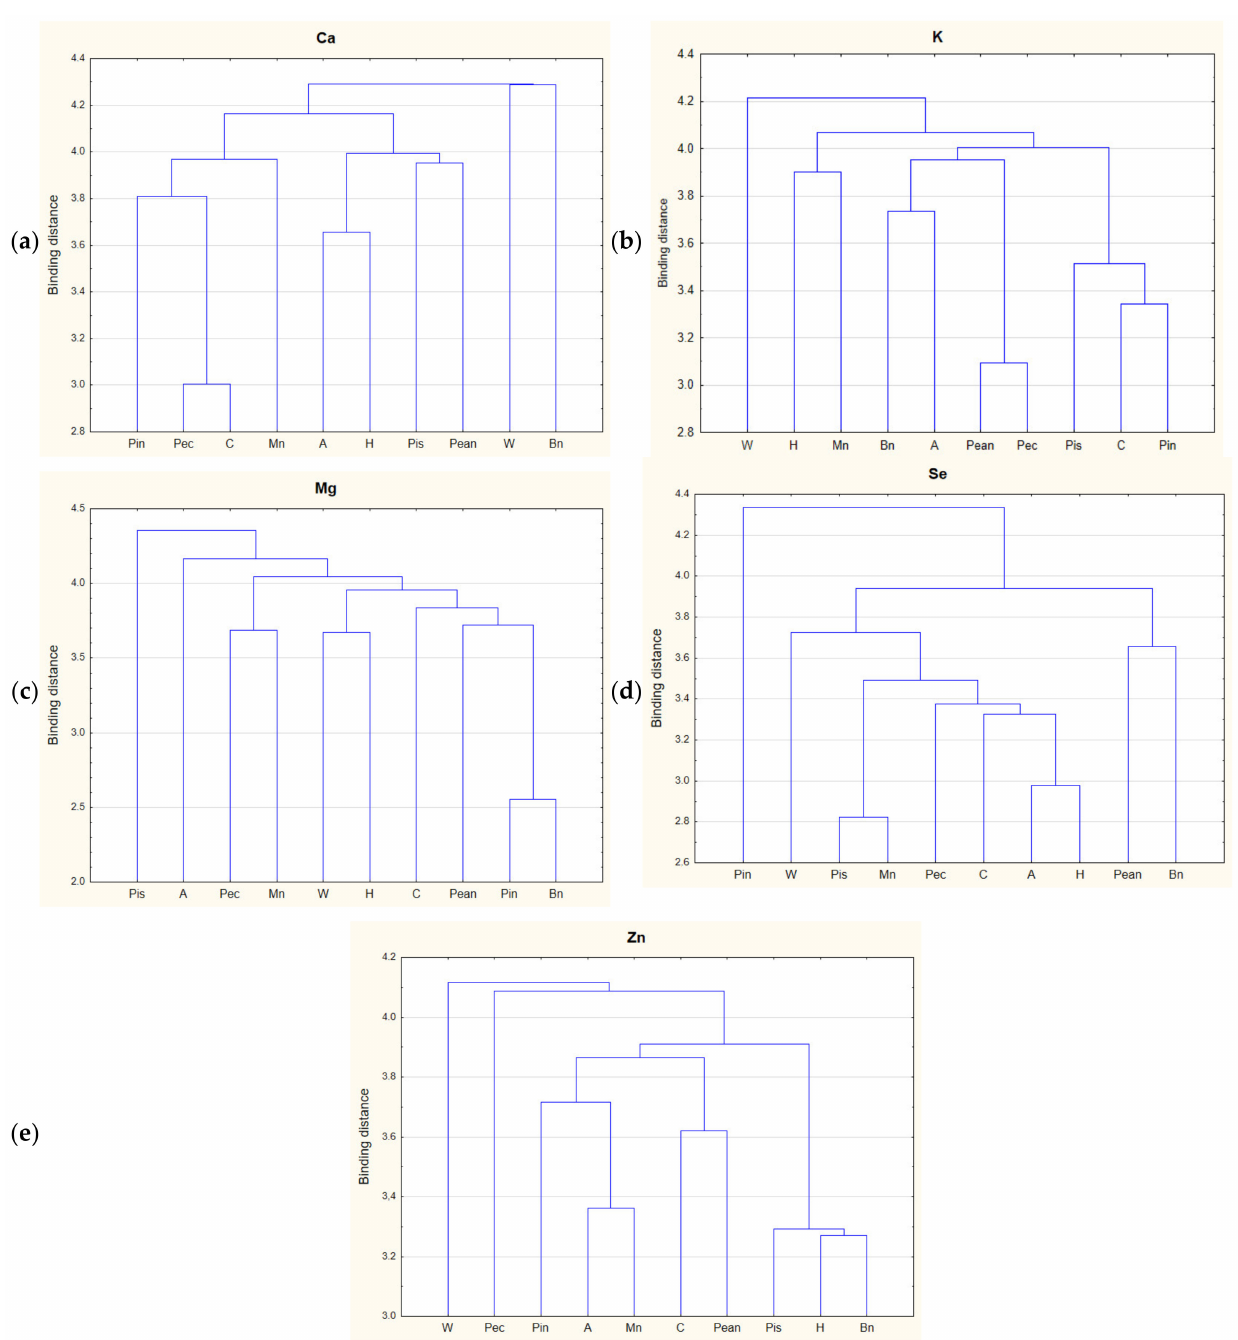
Figure 1. Analysis of the clusters of tested nuts: ( a ) calcium, ( b ) potassium, ( c ) magnesium, ( d ) se- lenium, and ( e ) zinc. Abbreviations: A—almonds, Bn—Brazil nuts, C—cashews,